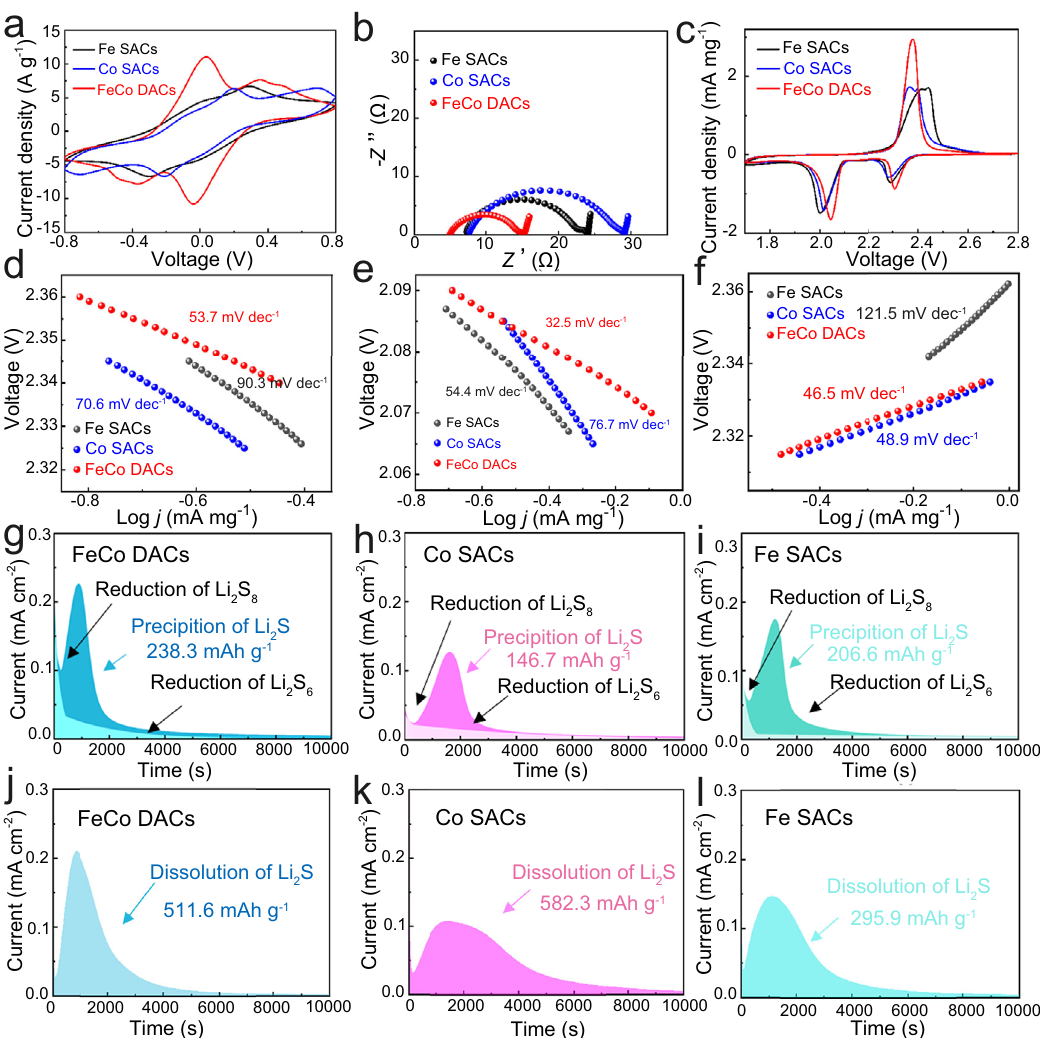
Fig. 4 | Bifunctional catalytic performance test. a CV curves of symmetric bat- teries ata scan rate of 5mVs − 1 . b Nyquist polts ofsymmetric batteries. c CV curves different cathode at 0.1mVs − 1 . d-f Corresponding Tafel plots of the CV